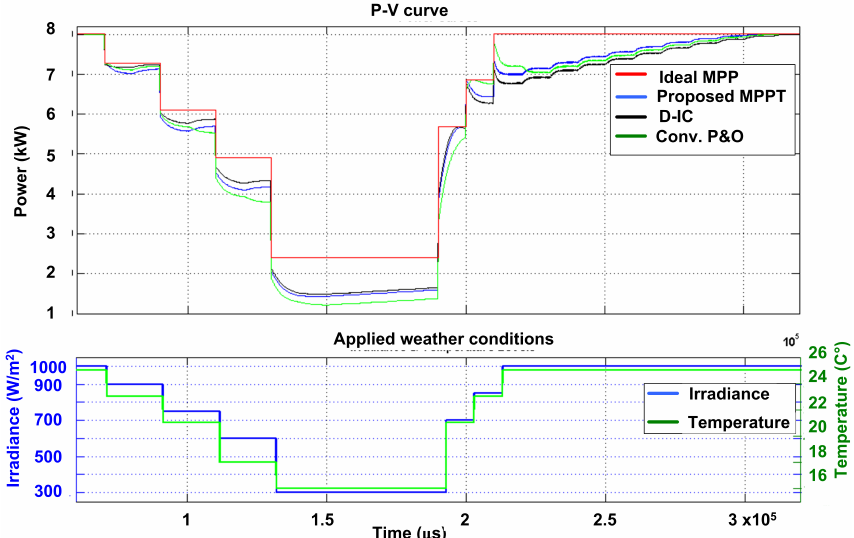
Figure 14. Case 5: Response of three algorithms under cloud